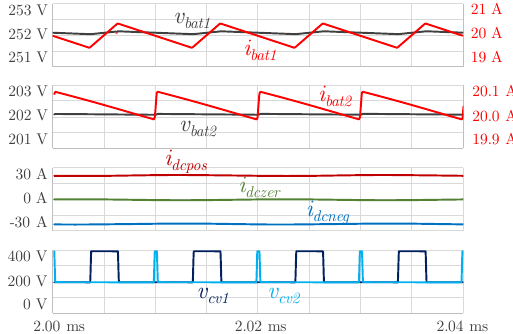
Figure 3. Simulation results of the G2V operation mode when EV1 and EV2 are charging with a current of 20 A.